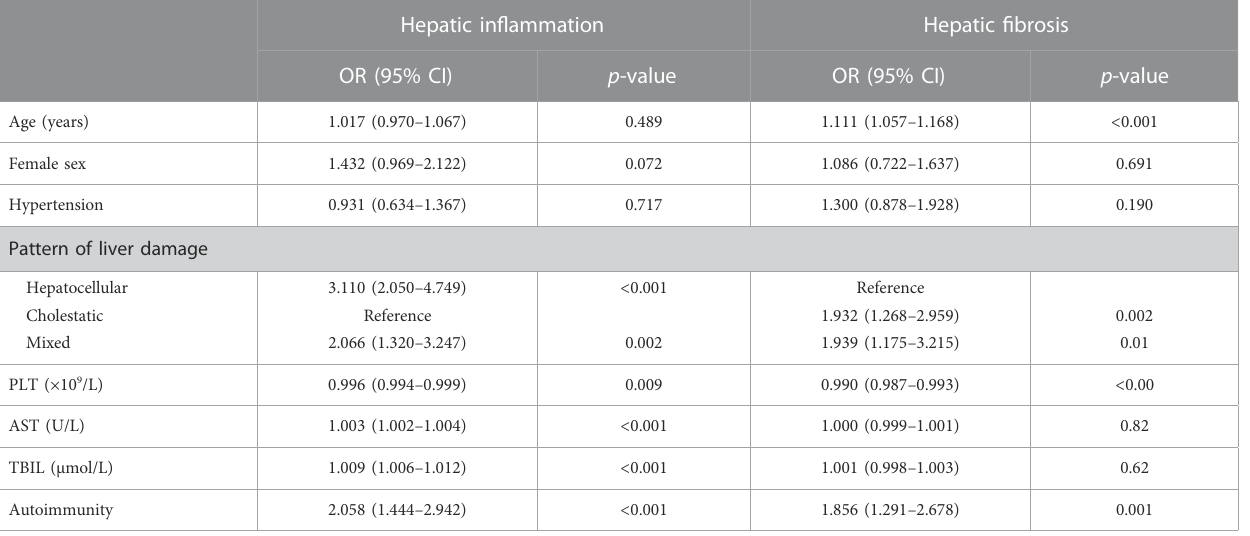
TABLE 3 Univariate ordinal polytomous logistic regression